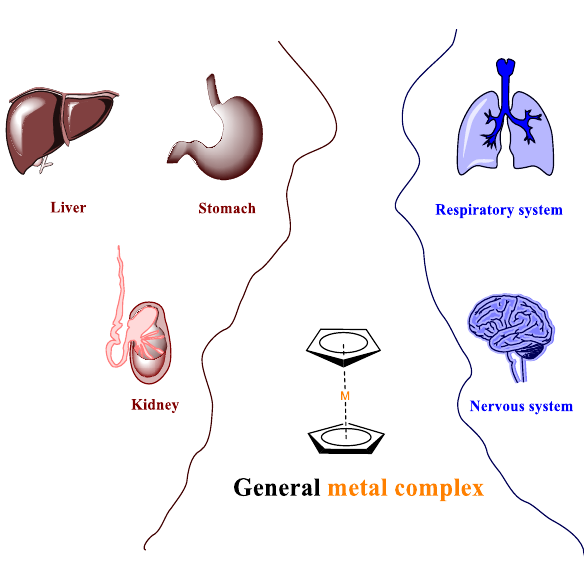
Figure 1. Toxicity of metallic catalysts in the human body.